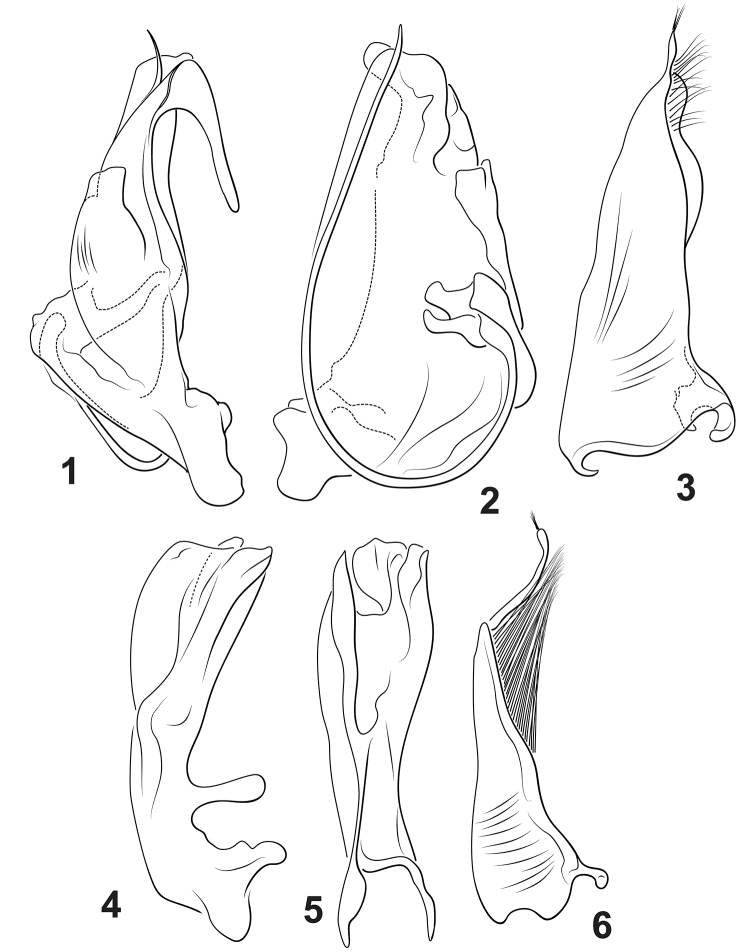
Agaporomorphus species, male genitalia. 1–3A.
hamatocoles1 male median lobe, right lateral aspect 2 male median lobe, ventral aspect 3 male right lateral lobe, right lateral aspect 4–6A.
tortus4 male median lobe, right lateral aspect 5 male median lobe, ventral aspect 6 male right lateral lobe, right lateral aspect.